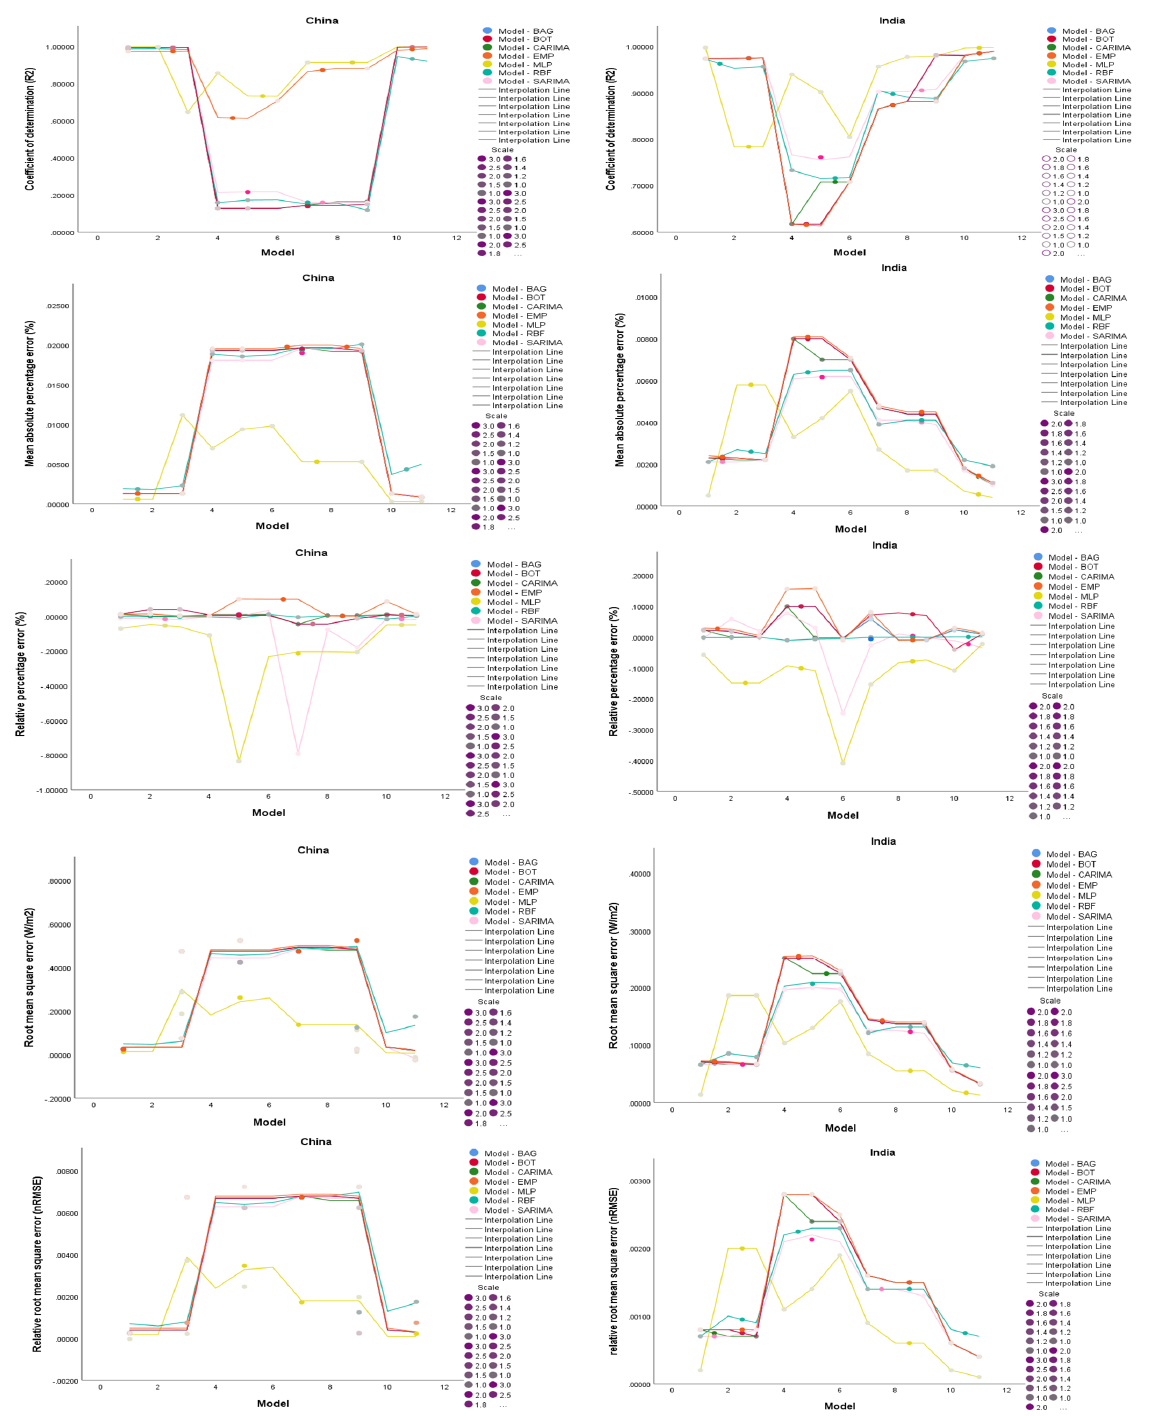
Figure 4. Performance analysis based on the error metrics of machine learning and empirical model fittings for China (left column) and India (right column).